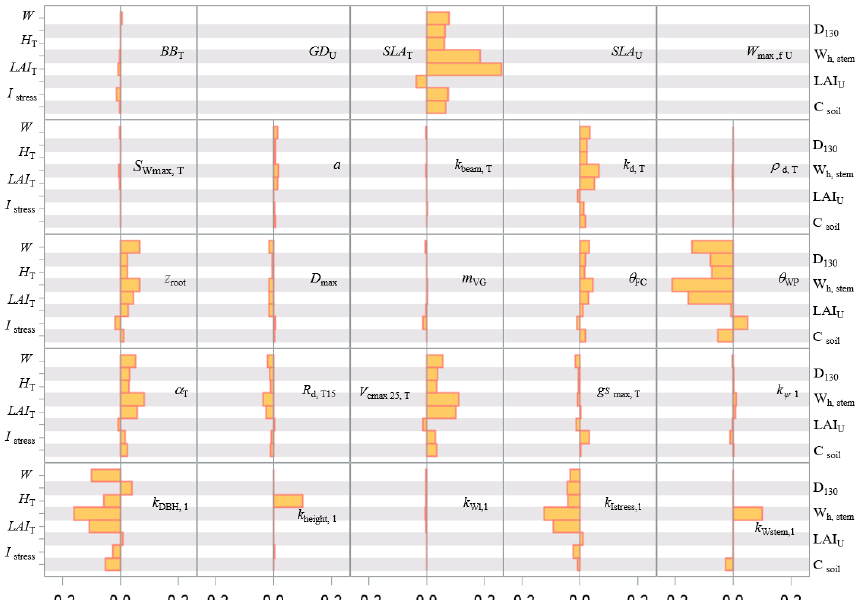
Figure 9. Sensitivity index values of the main variables related to the carbon stocks in biomass and soil to model parameters over a full rota- tion (1970–2010) at the Le Bray site. The abbreviations of the variables (vertical axes) are explained in Table A1 and parameter abbreviations (inset) are detailed in Table